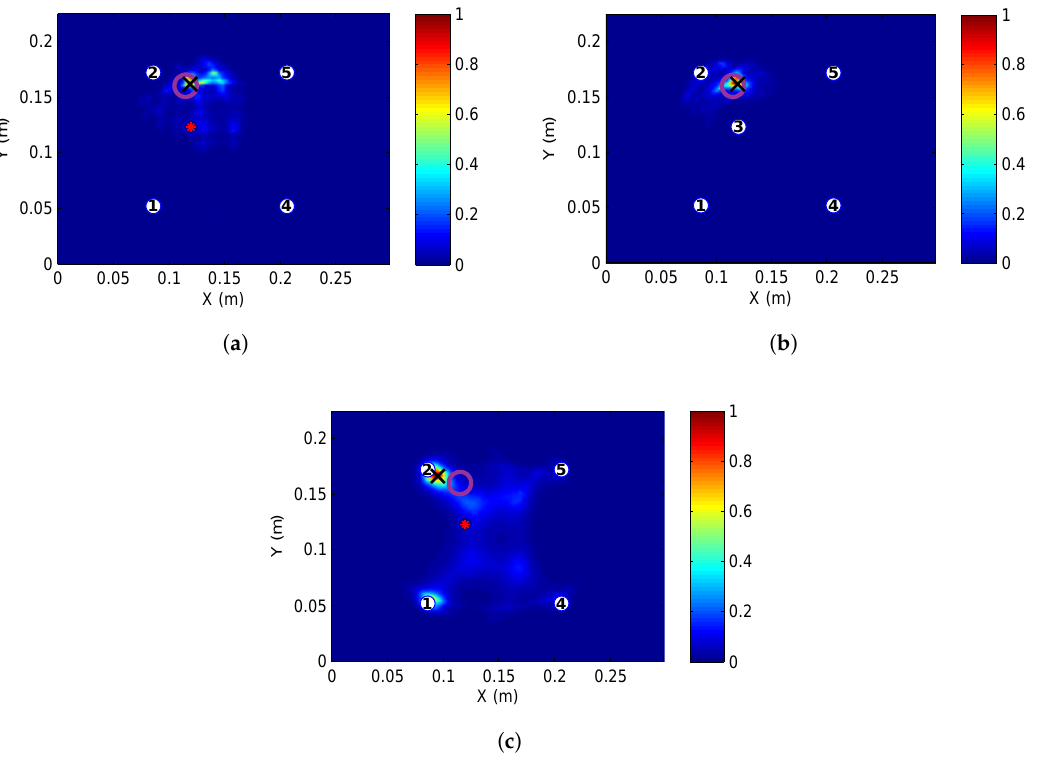
Figure 14. BVID impact localisation on the SHM layer CFRP plate, baseline at 25 ◦ C with compensated current signal. Temperature was varied between 31 and 38 ◦ C when the signal was being acquired: ( a ) 50 kHz, four transducers; ( b ) 50 kHz, five transducers; ( c ) 300 kHz, four